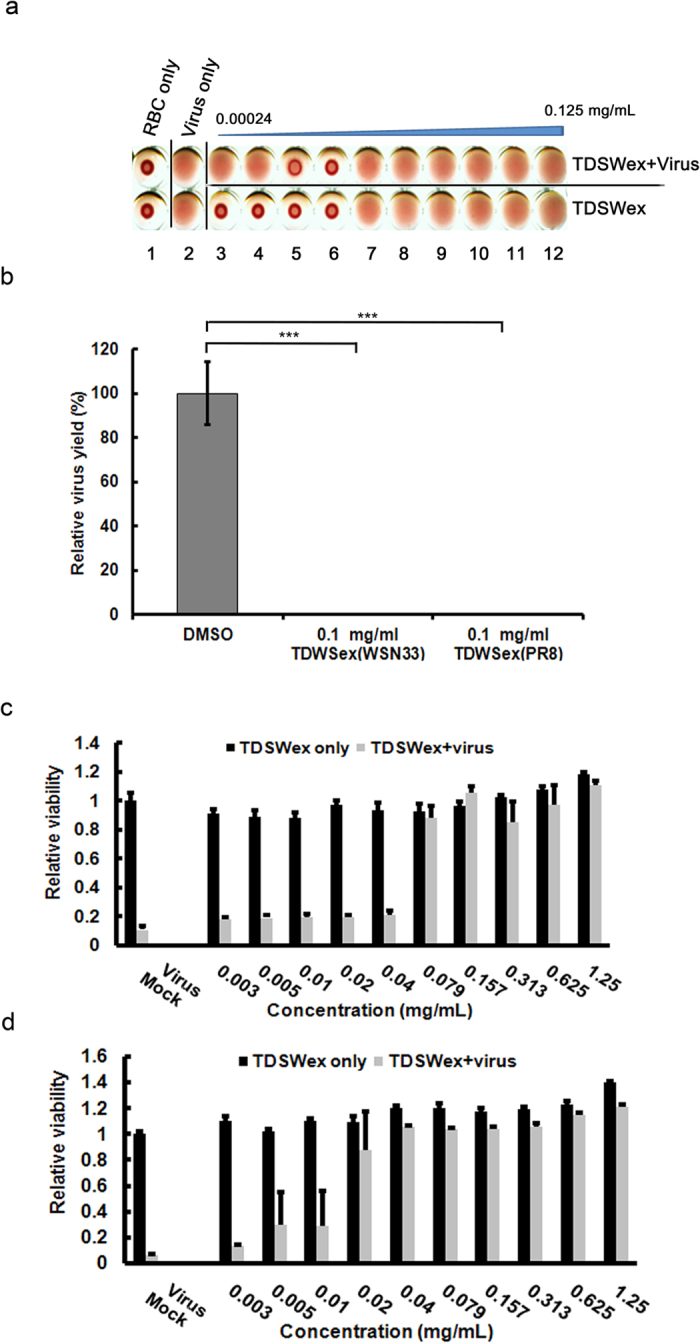
HI, viral particle inactivation, attachment, and penetration assays.(a) RBCs were incubated with influenza A/WSN/33 at 4 × HAv in the presence of different concentrations of TDSWex. The controls were RBCs mixed with DMSO (0.06%) in PBS, or virus mixed with DMSO (0.06%) in PBS. Twofold dilutions of TDSWex in PBS from 0.125 mg/mL to 0.00024 mg/mL are shown from right to left. (b) Viral particle inactivation assay. The viruses were preincubated with DMSO or TDSWex for 1 h and the resultant mixtures were diluted for titer determination. The viral titer from pretreatment with DMSO was set to 1, and the fold change of viral titers was presented as mean ± SD of the results of two independent experiments. ***p < 0.001. (c) Attachment assay. The cells were infected with 3 × TCID50 of WSN in the presence of different concentrations of TDSWex on ice for 1 h before incubated at 37 °C for three days. The results are presented as mean viability relative to control ± SD of results from three independent experiments. (d) Penetration assay. Cells were precooled before infected with 3 × TCID50WSN on ice. After removing unbound virus, the infected cells were incubated with medium containing TDSWex at 37 °C for 1 h followed by acid wash to inactivate the virus on cell surface. The protection against cell death mediated by TDSWex was measured by MTT assay. The results are presented as mean viability relative to control ± SD from three independent experiments.